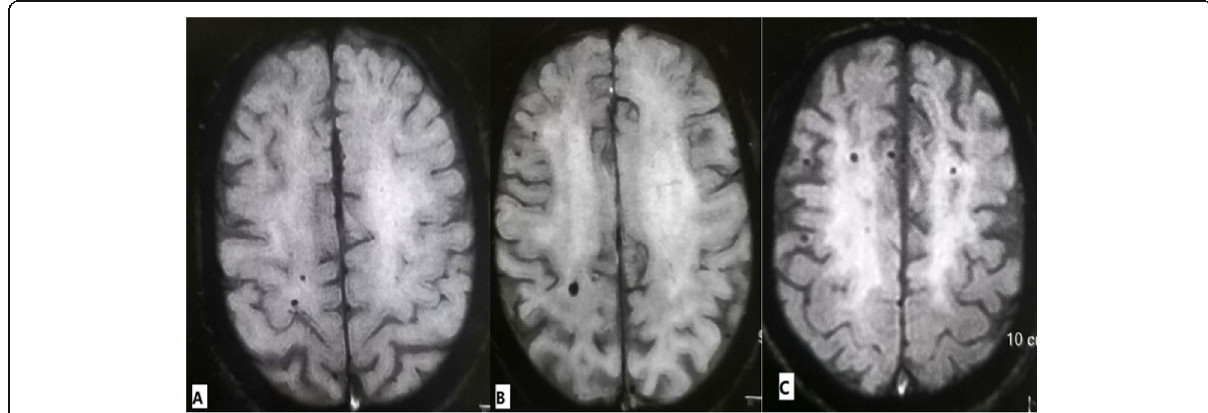
Fig. 1 Lobar type cerebral microbleeds. Axial brain SWI images ( a – c ) show multiple signal loss areas of cerebral microbleeds in the cortical gyri and subcortical white